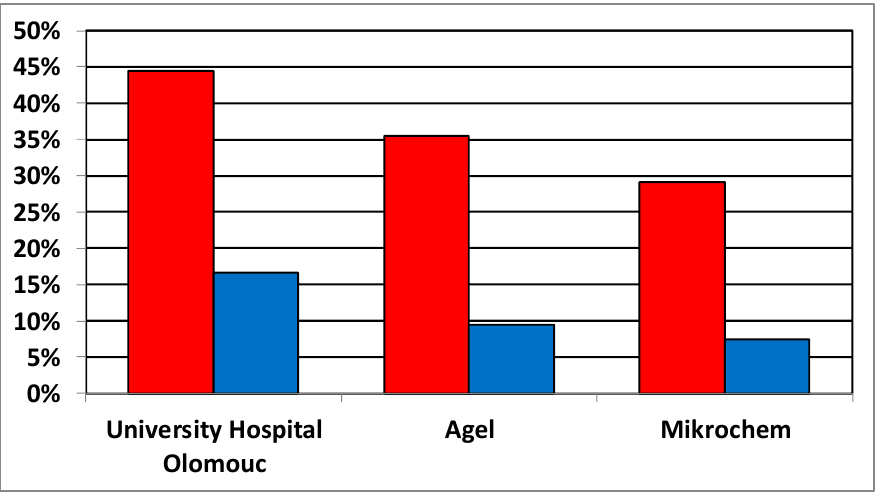
Figure 6. Comparison of the proportion of subjects indicated for revaccination based on the negative or borderline antibody levels issued based on manufacturer’s instructions in the preventive campaign (red) with the proportion of subjects having antibodies levels below generally accepted correlate of protection, i.e., <120 mIU/mL (blue). For the Mikrochem laboratories, the values were recalculated according to the ratio between the units used and the WHO standard provided in the manufacturer’s instructions. The data of the Šumperk Hospital laboratory could not be displayed due to the lack of connection to the mentioned standard.